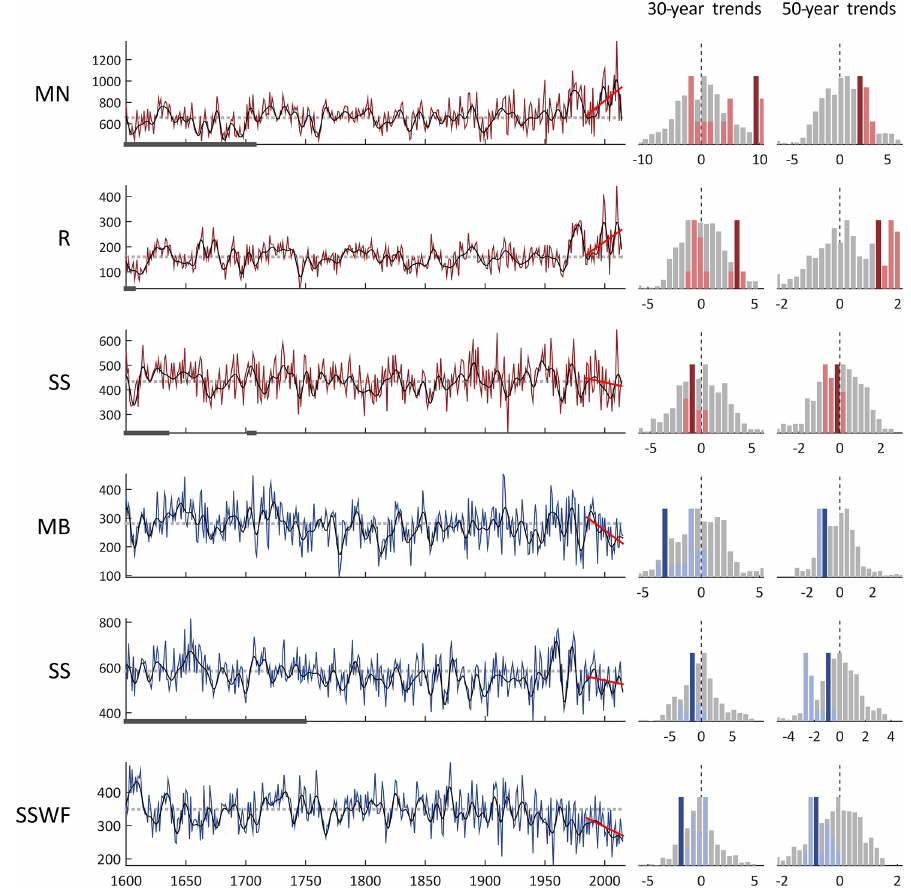
Figure 6. Contextualising recent observed trends in regional Australian rainfall. Left panels show regional rainfall reconstructions since 1600 for the warm (red) and cool season (blue) with the 10-year low-pass Chebyshev filtered series shown as a black line. Grey bars along the x axis denote non-verified periods for each reconstruction. Right panels show histograms of 30- and 50-year regional rainfall trends (mmyr − 1 ). Grey shaded bars indicate the full range of the trends prior to 1970 (for 30-year periods) and 1950 for 50-year periods. Light red/blue colouring highlights the trends since 1970 (for 30-year periods) or 1950 for 50-year periods. The dark coloured bars indicate the trend in the most recent period. Bar heights are normalised by the maximum occurrence for each